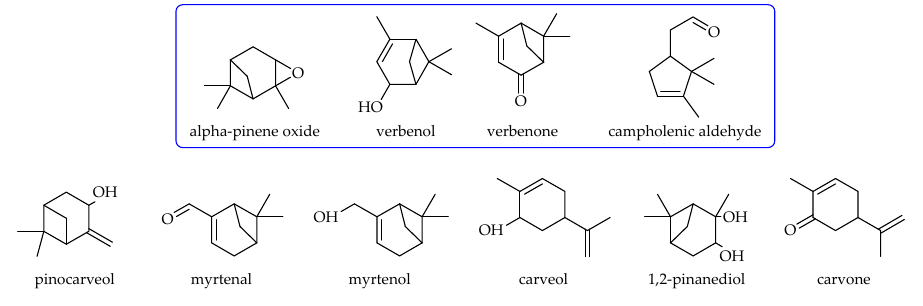
Figure 6. α -Pinene oxidation products.